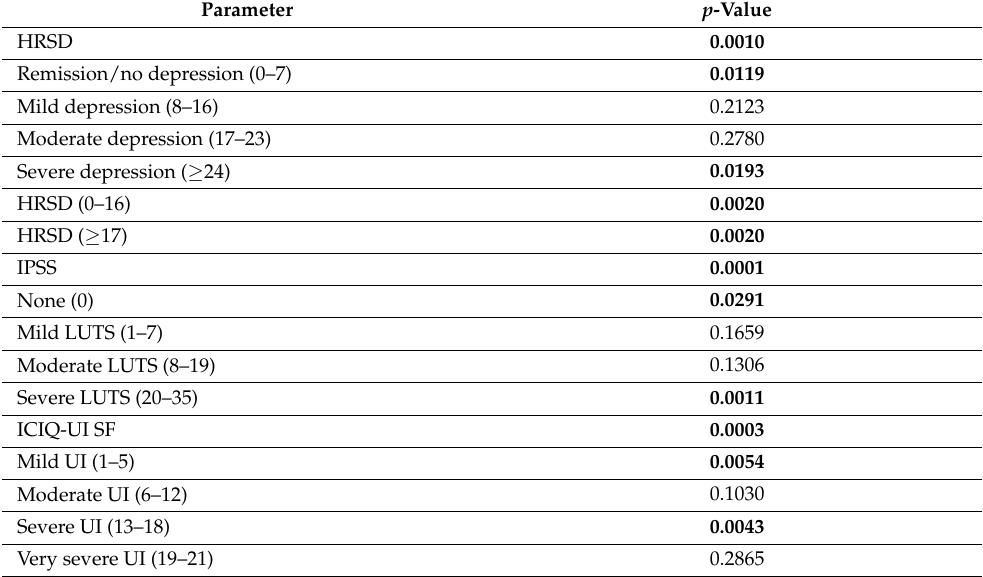
Table 4. Regression analysis of the effect of depression severity, lower urinary tract symptoms (LUTS) assessed with IPSS, and urinary incontinence (UI) assessed with the ICIQ-SF UI on sleep quality in patients with depression regardless of age and